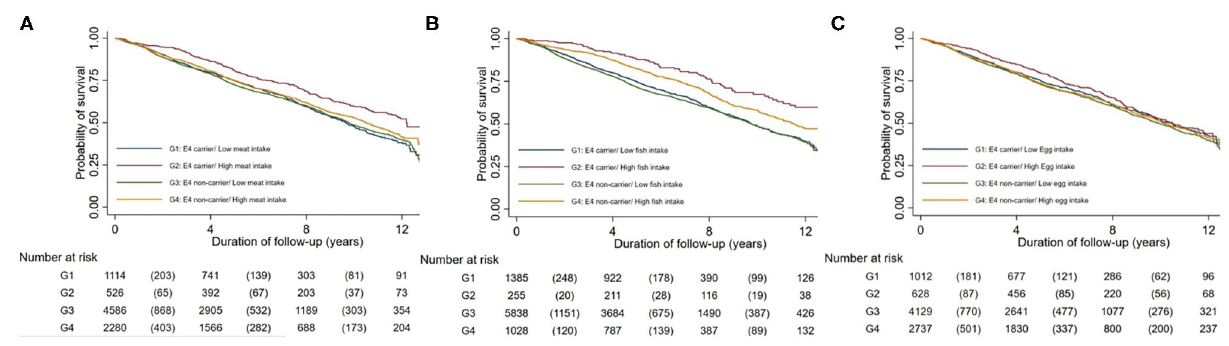
Frontiers in Medicine |